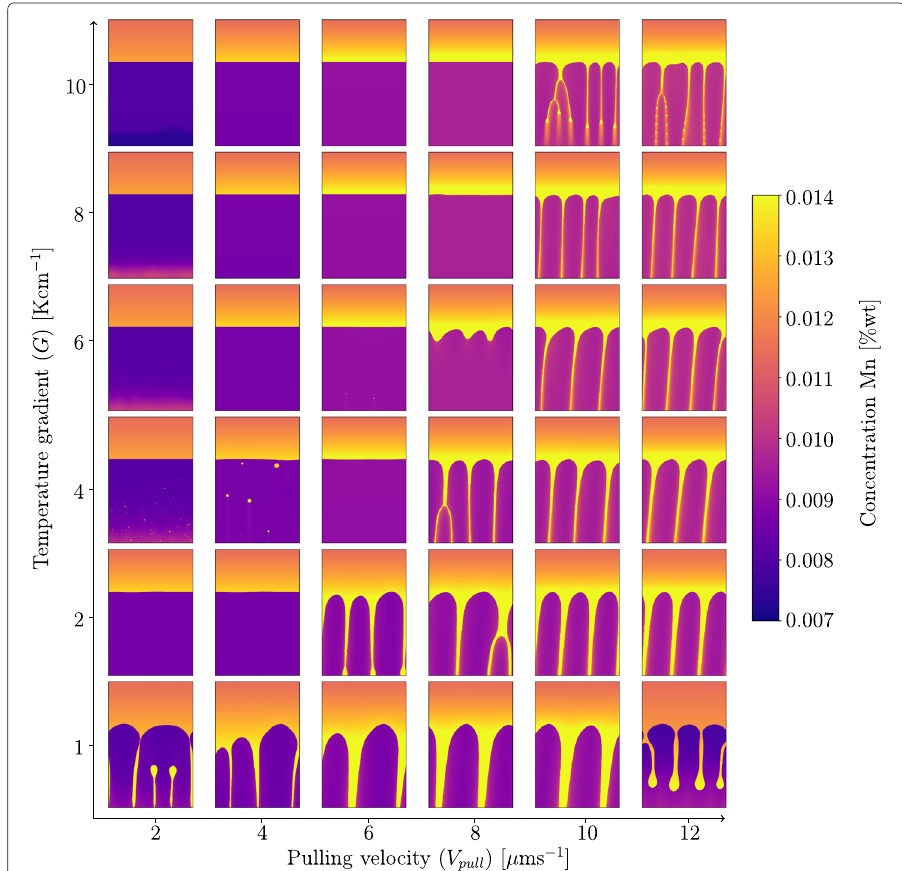
Fig. 8 Concentration map of Mn at 400 s for different pulling velocities (V pull ) and temperature gradients (G)